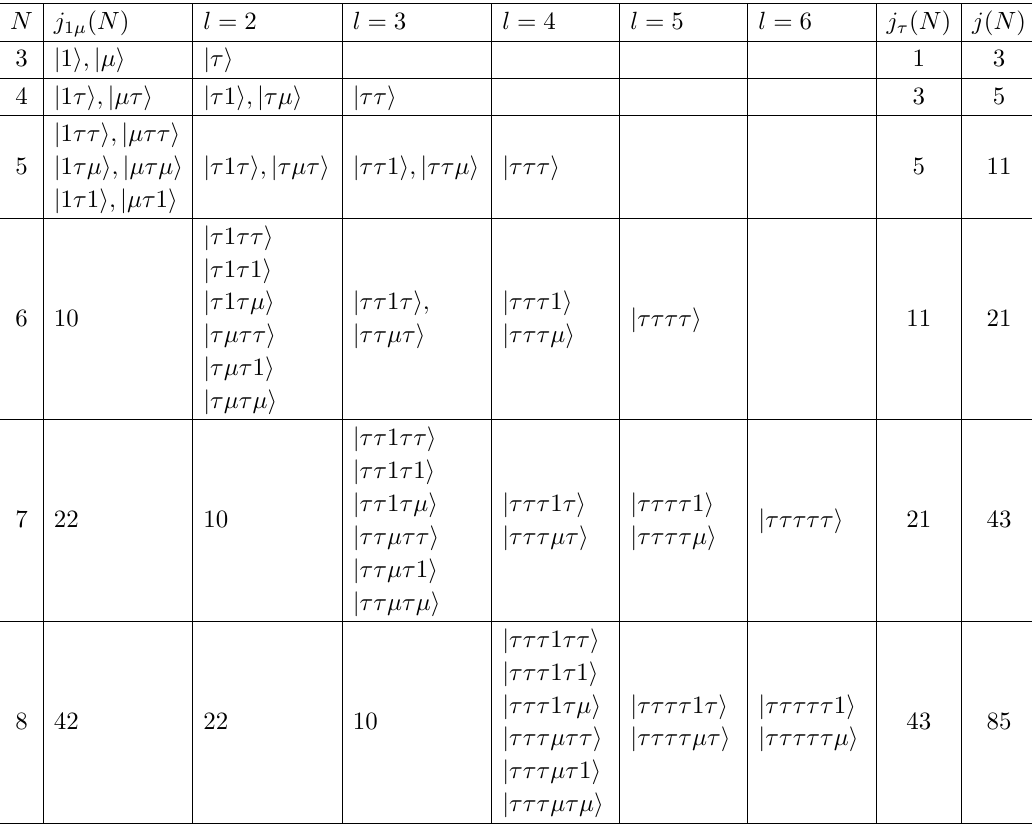
Table 6 . Number of basis states in the Jones-Kauffman anyons space. Here l denotes the first location where the sequence of τ is broken by 1 or µ